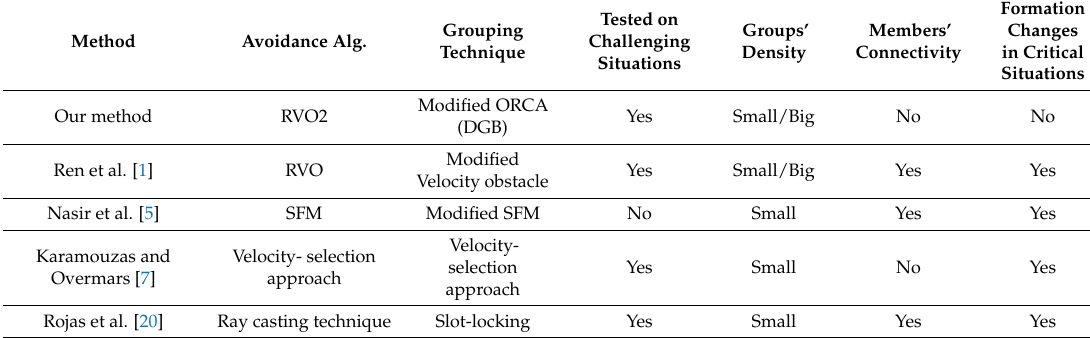
Table 1. Comparison between our method and the three recent similar